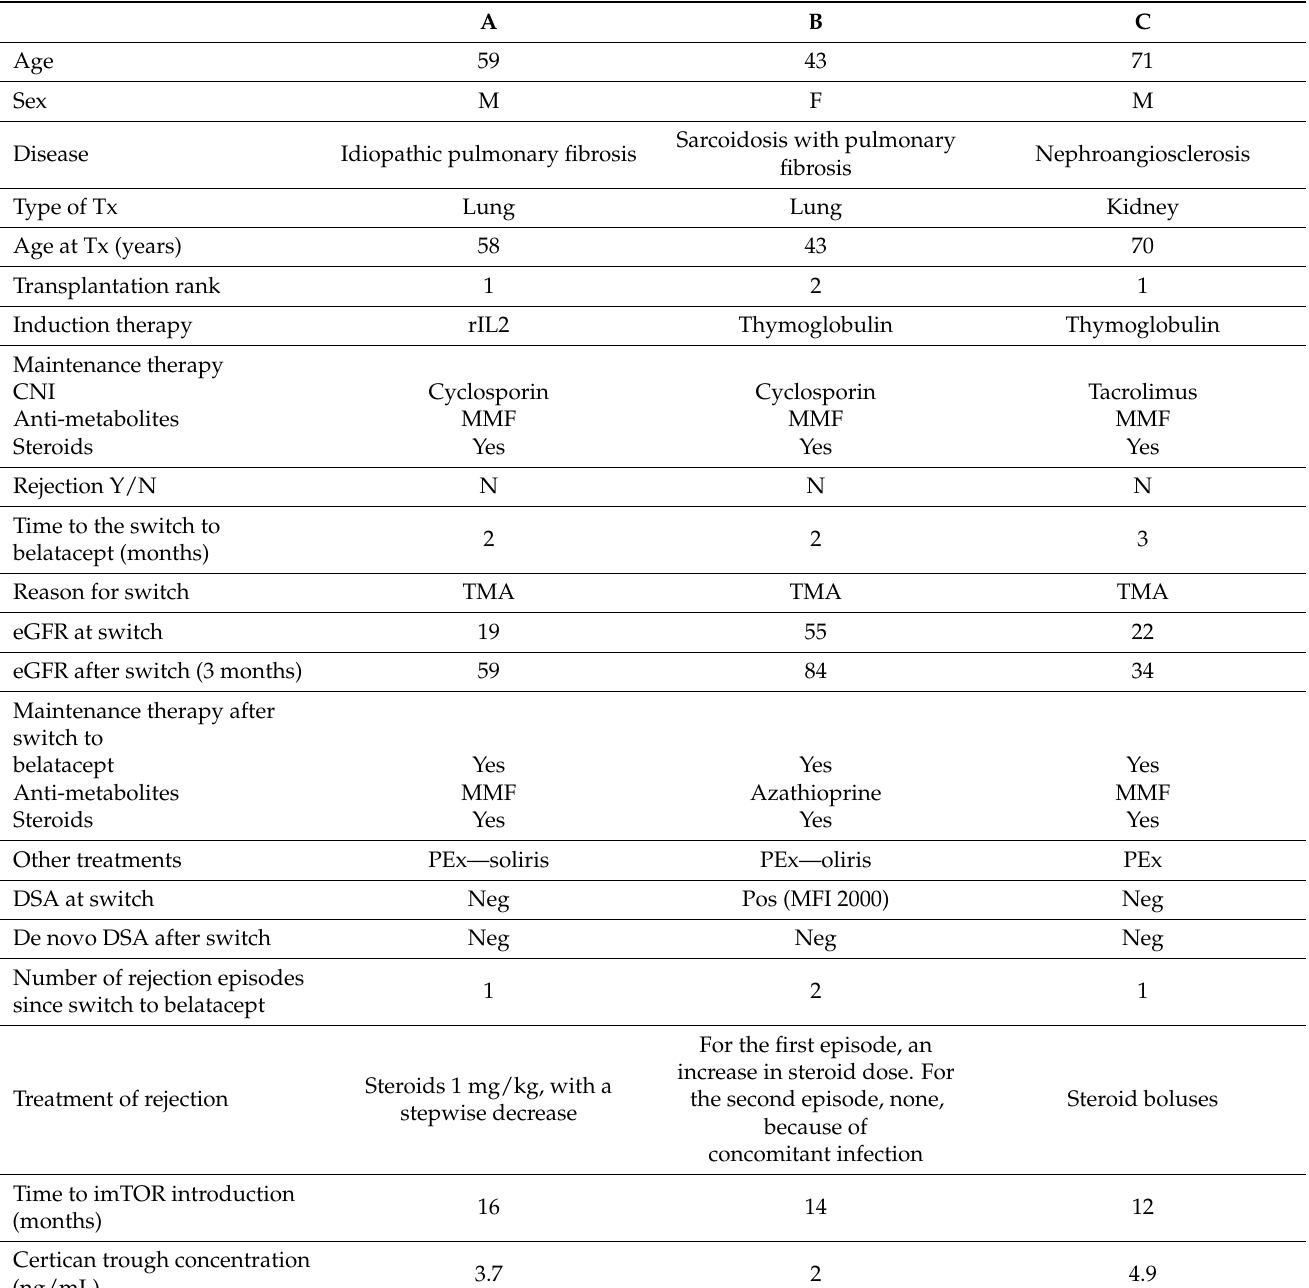
Table 2. Most of the T lymphocytes of these patients expressed CD38, a marker of activation, at the cell surface at the time of ACR. Following mTORi introduction, the proportion of CD4 + CD57 + cells did not decrease significantly. By contrast, the proportion of CD4 + T cells that were CD38 + decreased significantly, as did the proportion of CD8 + CD38 + T cells (Figure 6). This decrease in T-cell activation following mTORi treatment in vivo should be considered in light of the inhibition of the different T-cell subsets in vitro. Table 1. Summary table of patient characteristics and treatments. A B